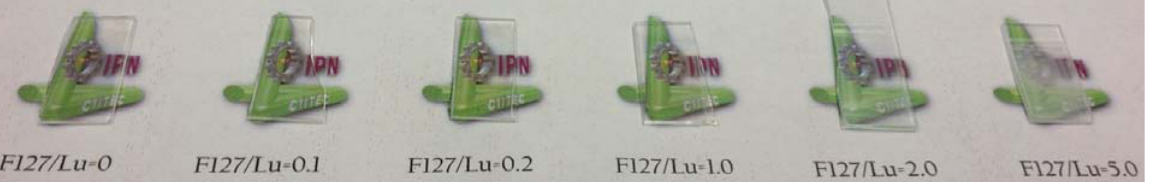
Figure 3. Photograph of transparent Lu